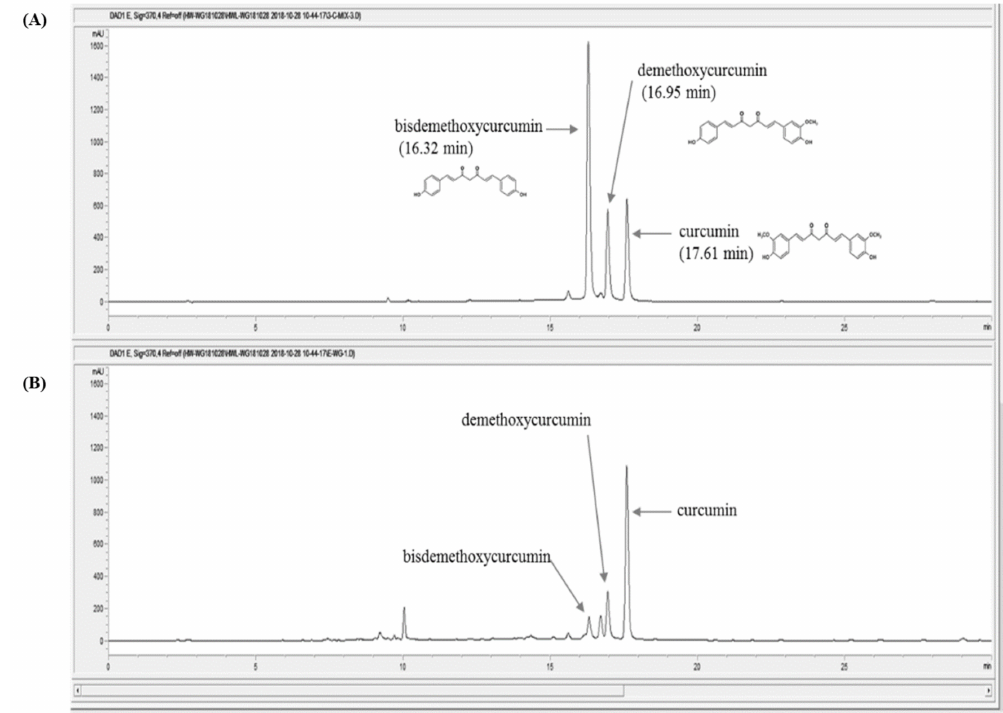
Figure 1. High-performance liquid chromatography (HPLC) chromatograms of Curcumae radix extract and three reference compounds at 370 nm. ( A ) Three reference standards (curcumin, demethoxycurcumin, and bisdemethoxycurcumin), ( B ) Curcumae radix ethanol